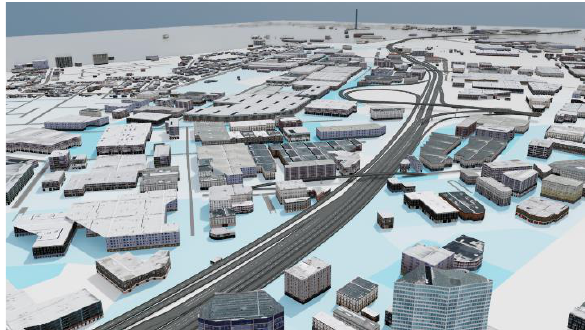
Figure 6: Shows the 3D freeway and buildings visualised over the flood extent and depth data. Image credit Anna Müeller